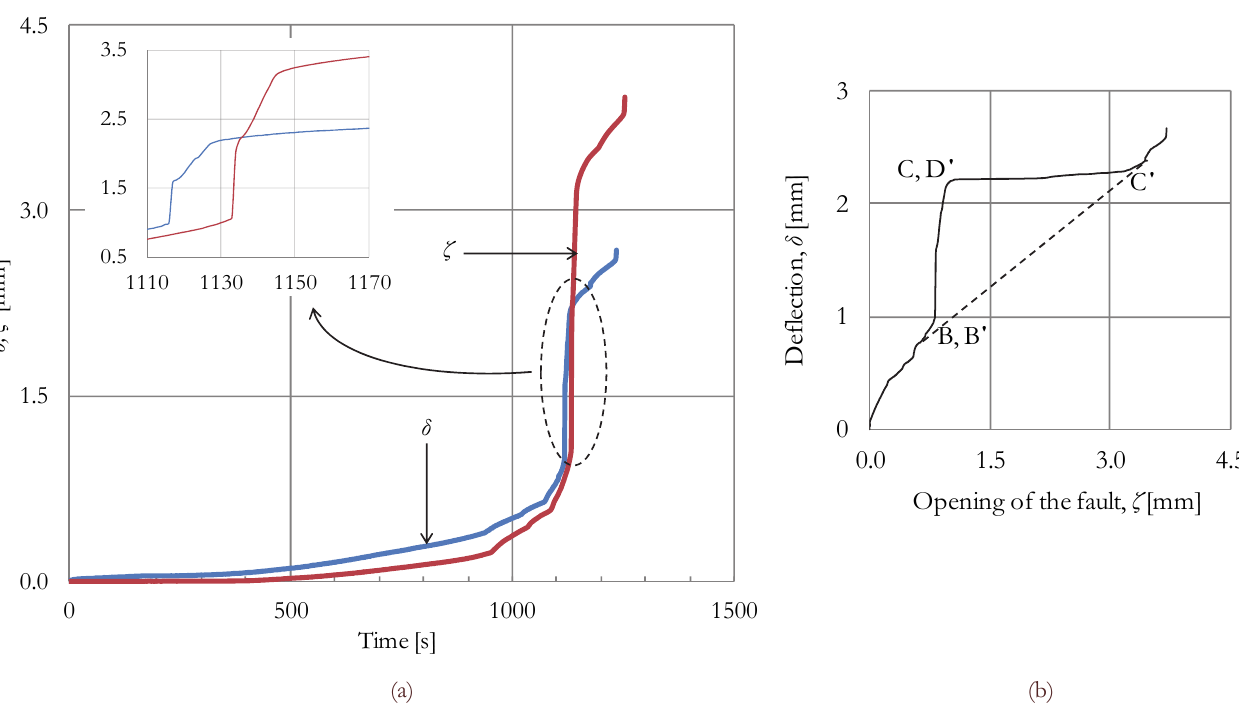
Figure 5: (a) The time evolution of deflection, δ , of the epistyle’s central section and of the opening of the fault, ζ , at the lowest edge of the epistyle. (b) The dependence of δ on ζ